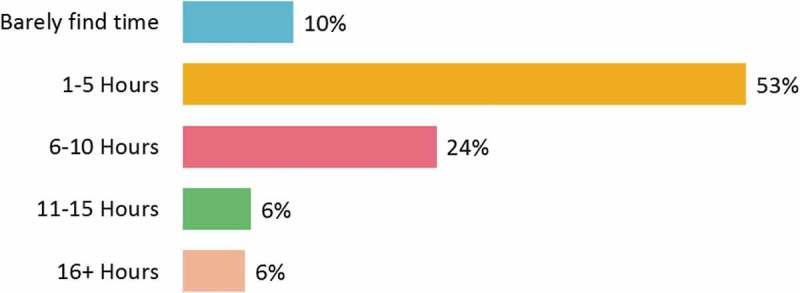
Time spent on the internet (online) for medical education purposes per week (n = 746).